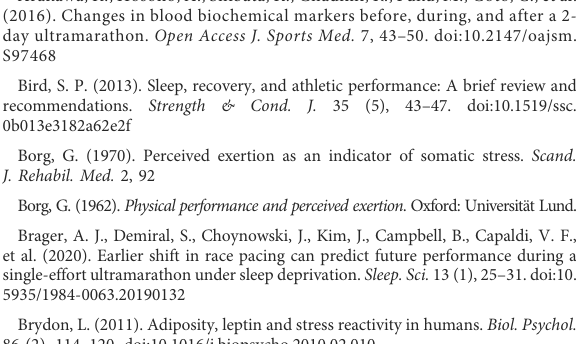
SUPPLEMENTARY FIGURE S1 POMS-SF scores at the four different time points and the three groups: fi nisher(FIN,darkgrey),non- fi nisher(NON,middlegreydottedline),and control (CON, light grey dotted